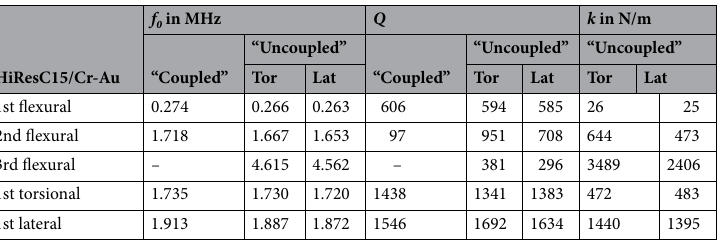
Table 1. Resonance frequencies, quality factors and force constants of the “coupled” and “uncoupled” cantilevers HiResC15/Cr-Au. The cantilever indexed by “Tor” was used for the images taken in AMFlex2- FMTor1-FMFlex3 mode and by “Lat” in the AMFlex2-FMLat1-FMFlex3